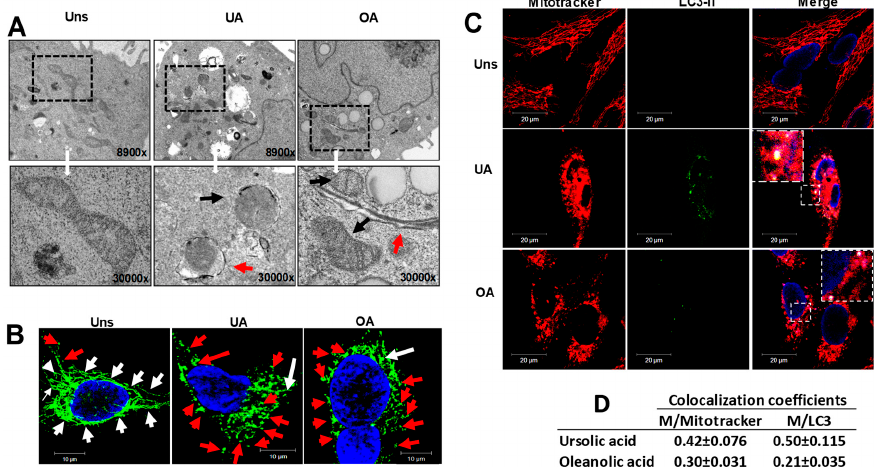
Figure 3. Ursolic and oleanolic acids promote mitochondrial morphology changes and induce mitophagy in A549 human lung cancer cells. ( A ) Cells unstimulated (Uns) or stimulated with 10 µ g / mL ursolic acid (UA) or with 20 µ g / mL oleanolic acid (OA) for 48 h were fixed with 2.5% glutaraldehyde and post fixed with 1% osmium tetraoxide. Subsequently, the cells were dehydrated with ethanol and embedded in resin, and sections of 50 nm were obtained with an ultramicrotome. The field magnifications are shown in large squares. Black arrows show the swollen mitochondria, with loss of cristae structure and increased mitochondrial lumen, while red arrows show mitochondria inside or near of double-membrane vesicles. ( B ) After treatment, the cells were incubated with MitoTracker Green (200 nM). White arrows show fused mitochondria; red arrows show fissioned mitochondria. ( C ) The treated cells were stained with MitoTracker Red (200 nM), fixed with paraformaldehyde 4%, washed with PBS and incubated with anti-LC3 A / B antibody at 4 ◦ C overnight, and subsequently incubated with secondary antibody at 37 ◦ C for 4 h. The large squares show a magnification of the area indicated in the small square and colocalization of the fragmented mitochondria and autophagosomes is shown. ( D ) The quantitative colocalization analysis of Mitotracker with LC3-II signals (M / Mitotracker) and LC3-II with Mitotracker signals (M / LC3-II) was performed with ImageJ Fuji to determine Mander´s coefficients from 0 to 1 (0 = non-overlapping images and 1 = colocalized